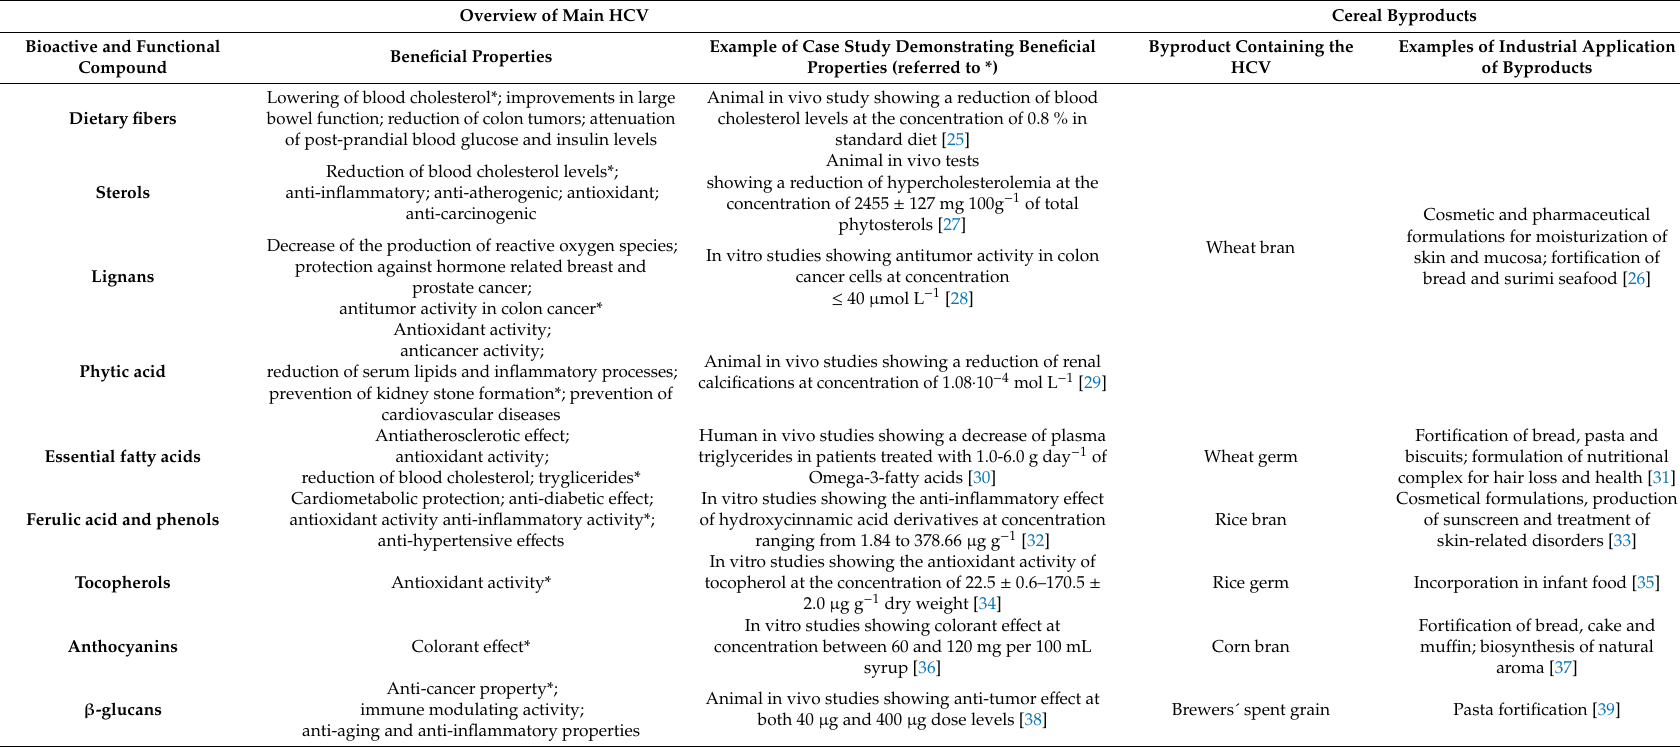
Table 2. Overview of the main HVC. Beneficial properties and corresponding examples of cereal byproducts in which they are present and industrial applications of byproducts with other derived technological e ff